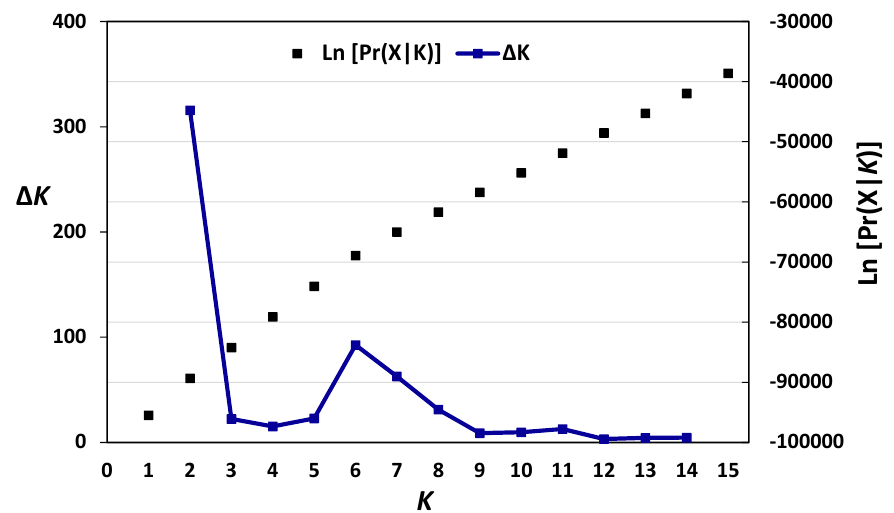
Figure 2. The log-likelihood and Δ K values based on the change rate of log-likelihood function between successive K [41] in the 70 Austrian wheat genotypes.